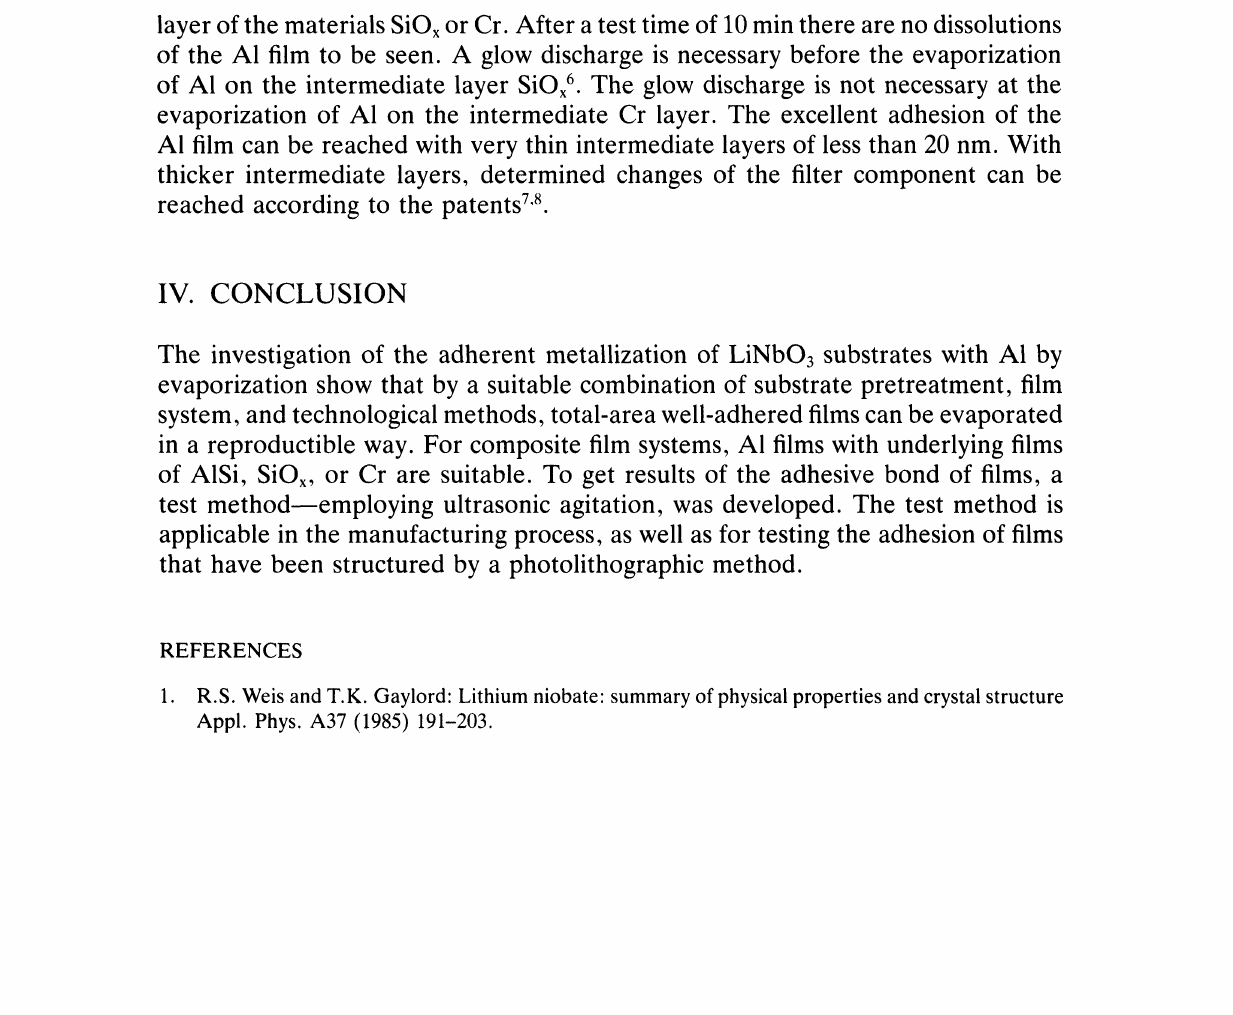
FIGURE 3 Area without layer after ultrasonic test of AI film and AI films with below mixed films of AISi, AICu and AINi on LiNbO3 in